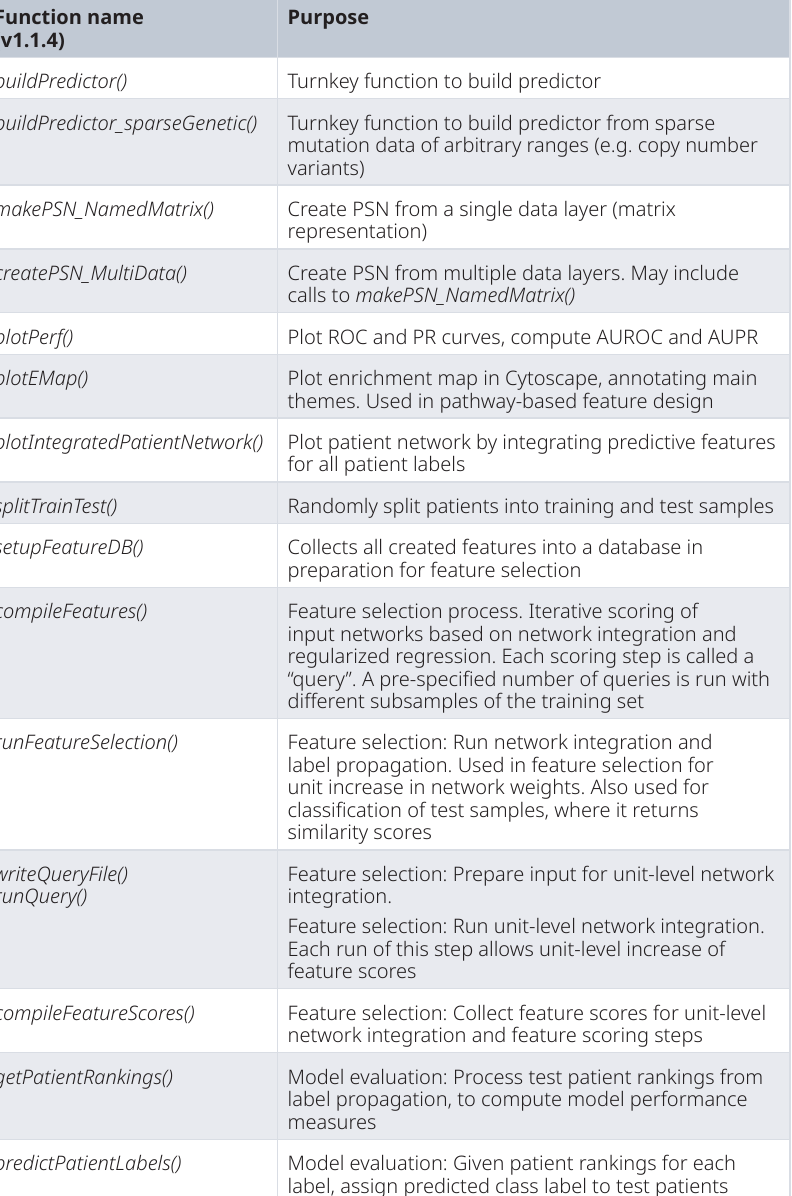
Table 1. Major functions for basic and advanced model-building, and result evaluation. Intermediate functions used to prepare data are not shown, but are illustrated in the use cases. The third column shows outdated names for these functions from the software release that accompanied the paper describing the methods. Function name